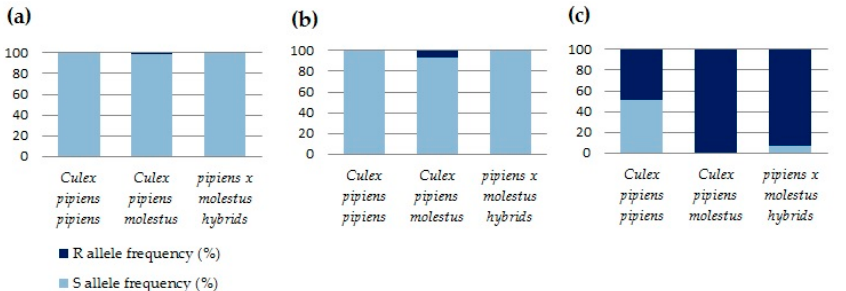
Figure 2. Allele frequencies for insecticide resistance genetic markers analysed in this study. ( a ):